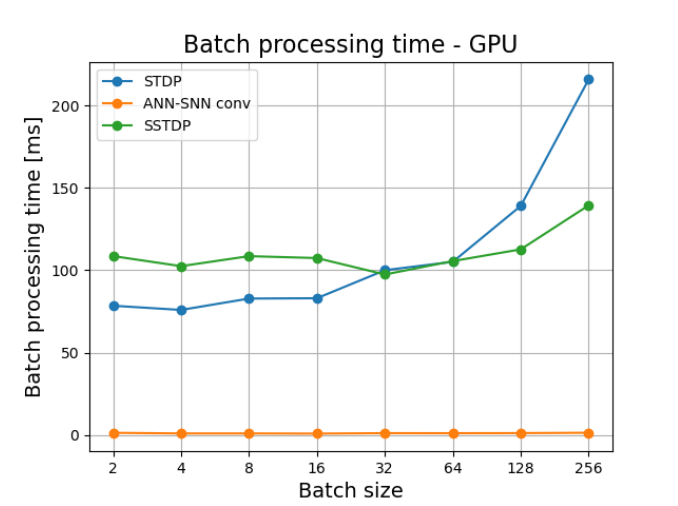
Figure 2. Batch processing times for different batch sizes on GPU.